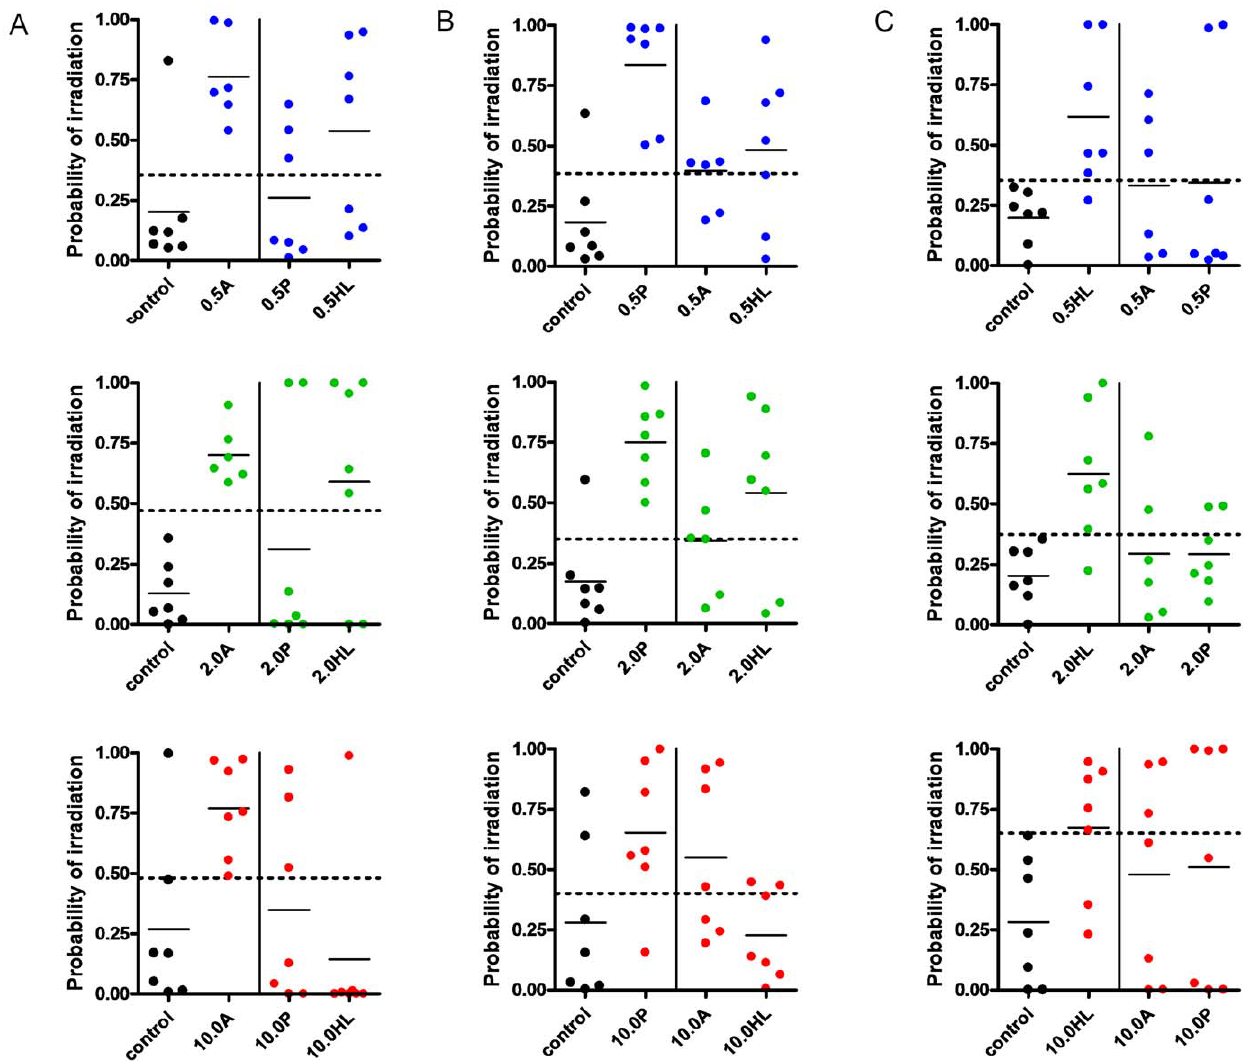
Figure 2. Gene expression profiles of partial body irradiation poorly predict the status of mice irradiated to disparate anatomic sites. A single variable plot is shown of the leave one out cross validation analysis performed in which the gene expression profiles of (A) AH irradiation were utilized to predict the status of mice irradiated to PH or HL at the identical dose levels (0.5 Gy, top; 2 Gy, middle; 10 Gy, bottom). (B) PB signatures of PH irradiation were tested against mice irradiated to AH and HL at 0.5 Gy (top), 2 Gy (middle) and 10 Gy (bottom). (C) PB signatures of HL were tested against mice irradiated to AH and PH at 0.5 Gy (top), 2 Gy (middle) and 10 Gy (bottom). Positive prediction of radiation status is defined by plotting of the sample above the ROC curve-defined cutoff (dotted line). Each dot represents a PB sample from an individual